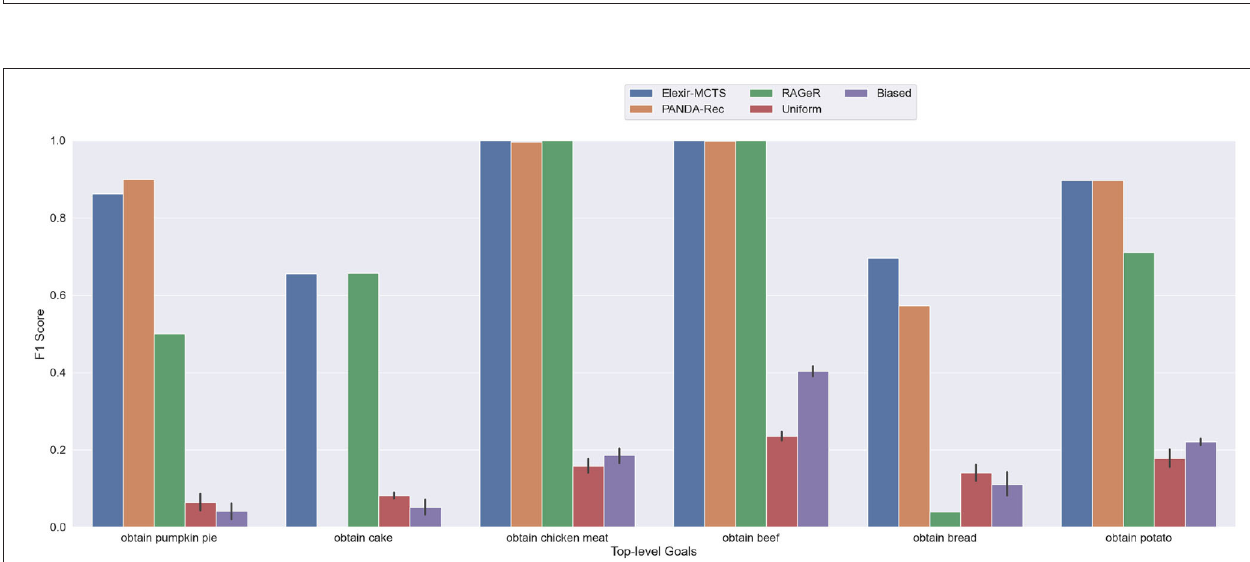
FIGURE 7 | Performance of PANDA-Rec, Elexir-MCTS, RAGeR, and two baselines (Random Uniform and Random Biased Recognition) over the low-inspectability Minecraft traces . Metric shown in the figure is the F1 score for each top-level goal in the Minecraft domain. Random Uniform and Random Biased bars are calculated for each top-level goal by taking the average F1 score over 10